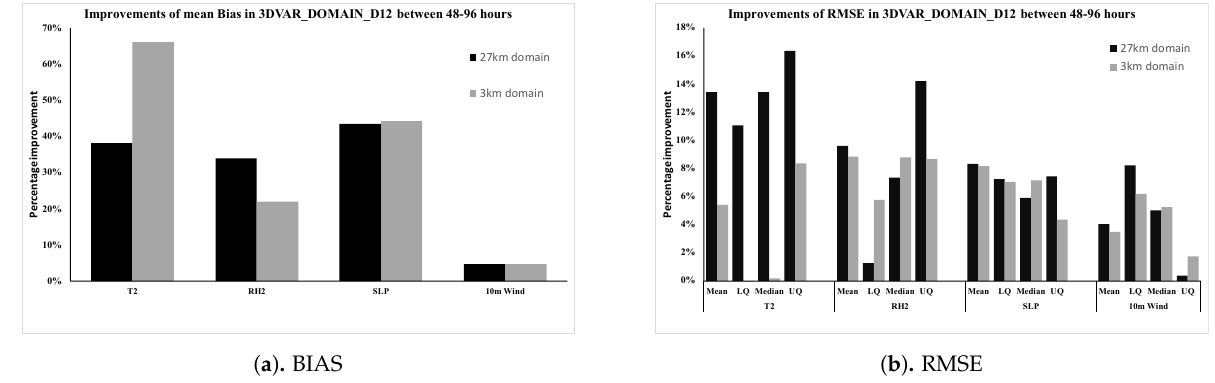
Figure 7. The percentage improvements of BIAS time and RMSE time for the case 3DVAR_DOMAIN_D12, comparing to